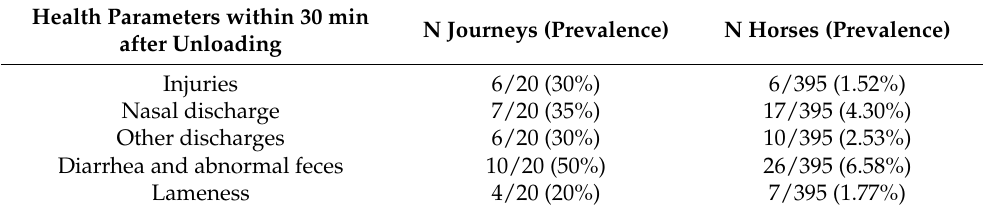
Table 10. Prevalence of health parameters observed within 30 min after unloading for the unbroken horses ( n = 395) transported to the slaughterhouse in Southern Italy. The health issues are reported as the number of journeys with animals displaying the health issue on the 20 journeys and as the number of horses displaying the clinical sign on the 395